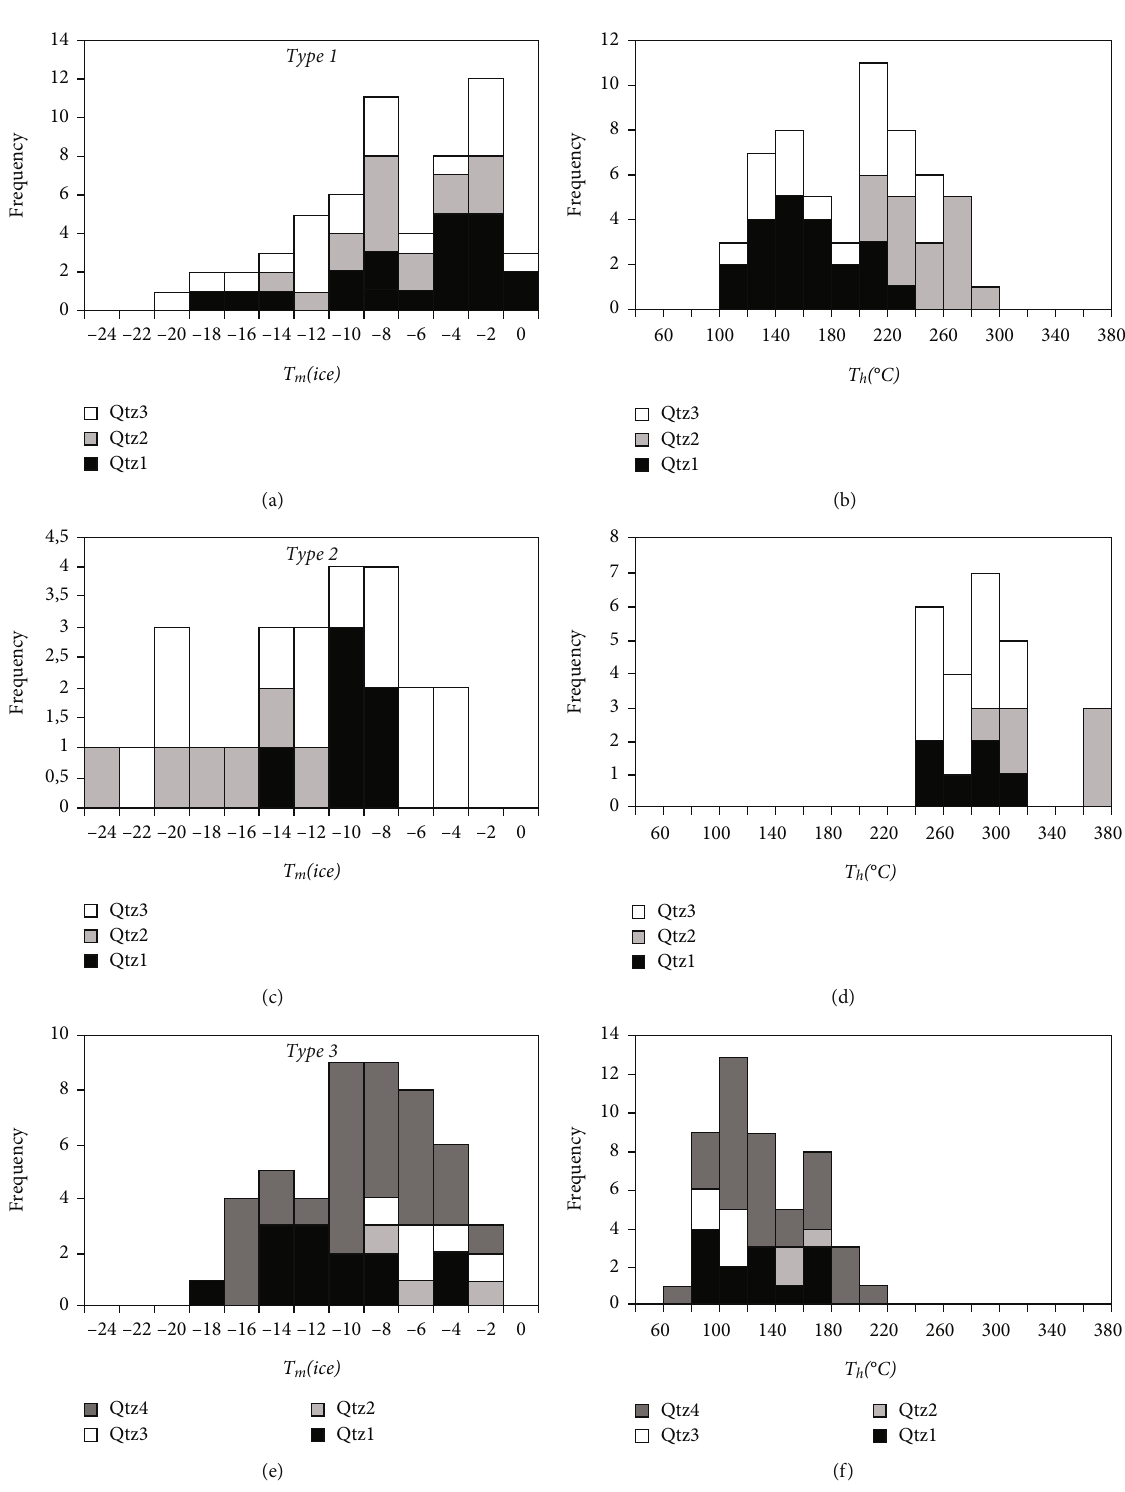
Figure 8: Histogram frequency of homogenisation temperatures ( T data of fl uid inclusions in mineralised quartz veins of the Roc Blanc deposit. (a, b) T m ð (type 1). (c, d) T m ð Homogenisation occurs into liquid phase or vapour phase (see description in the